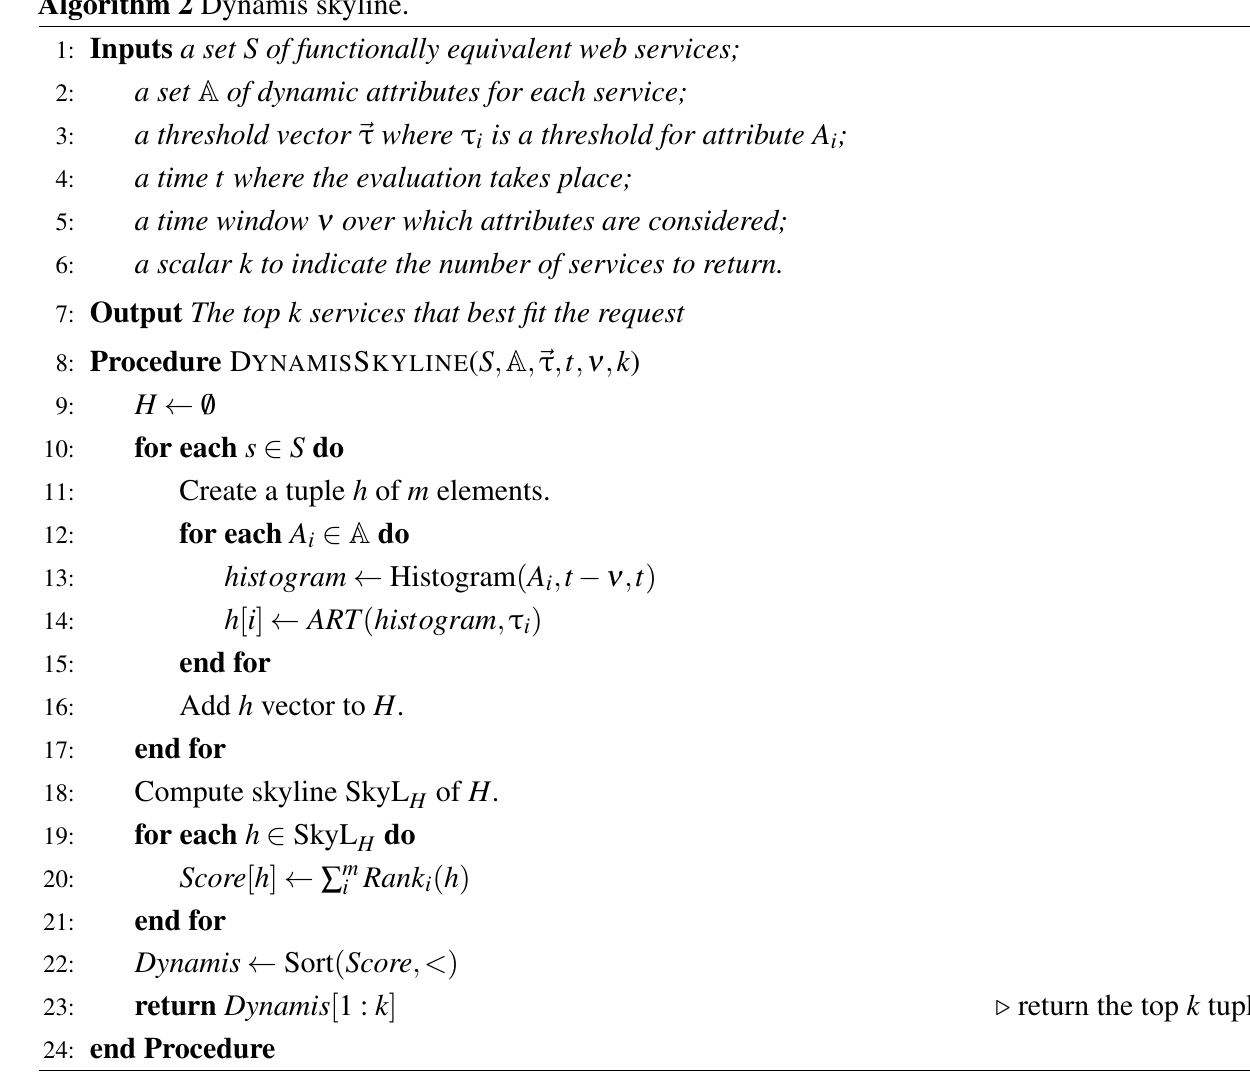
Algorithm 2 Dynamis